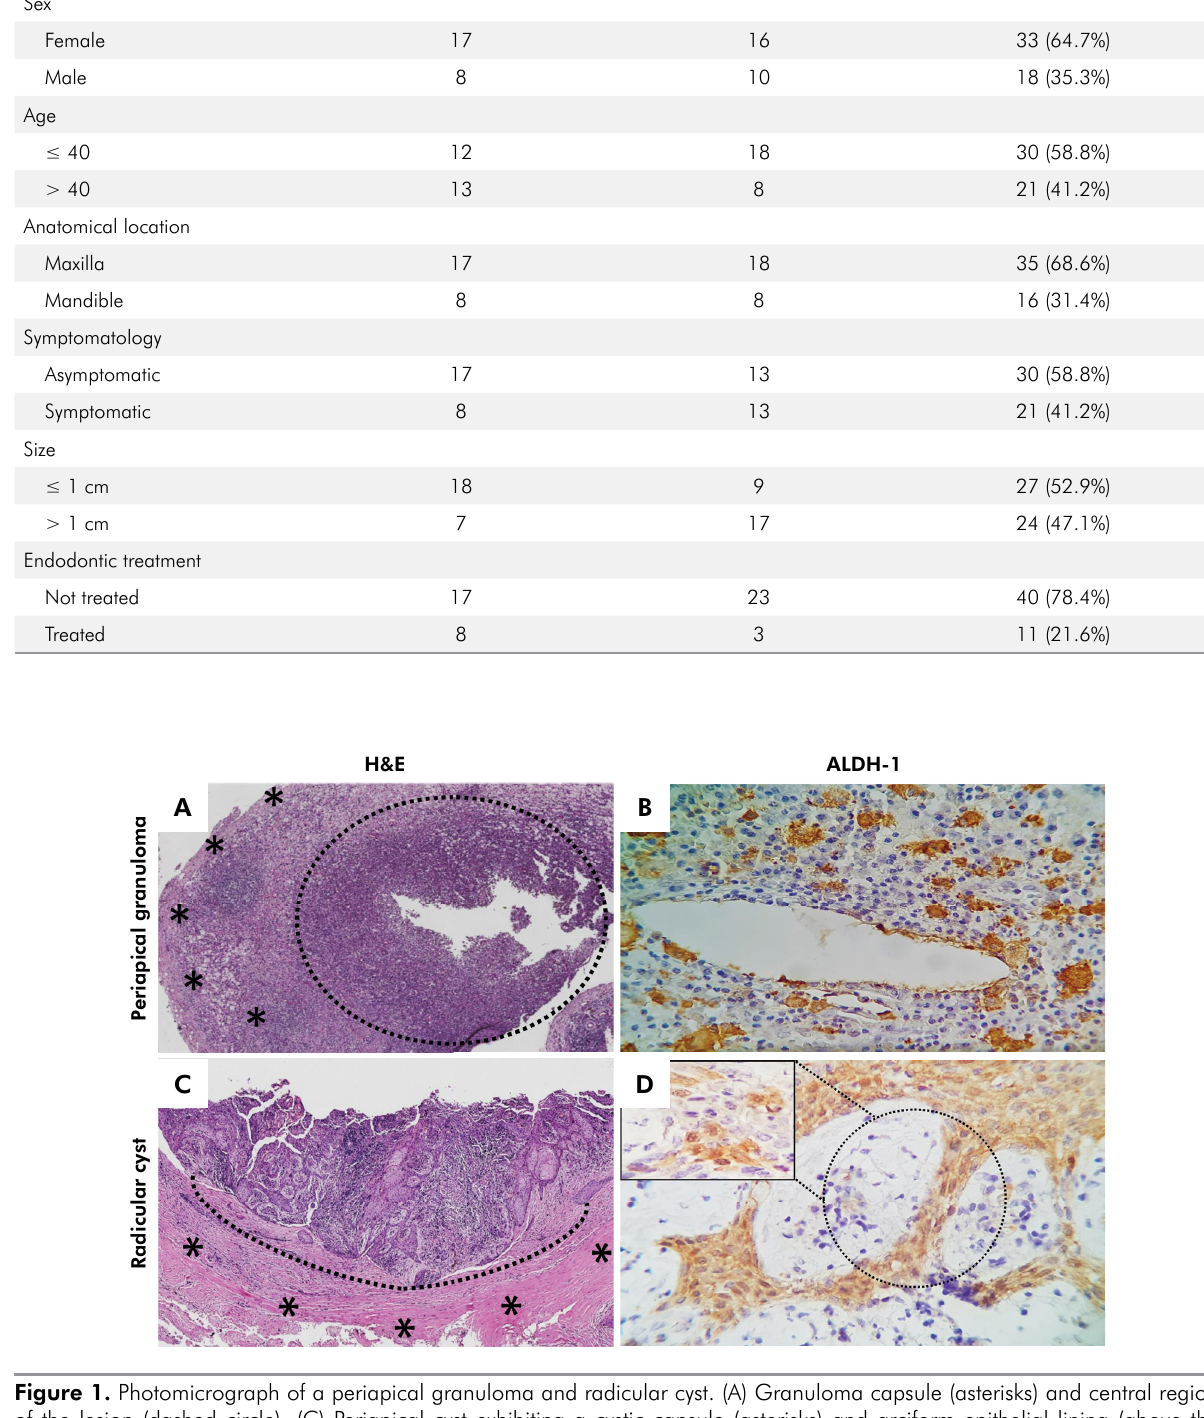
Table 1. Clinicopathologic data of individuals with periapical granulomas and radicular cysts. Variables